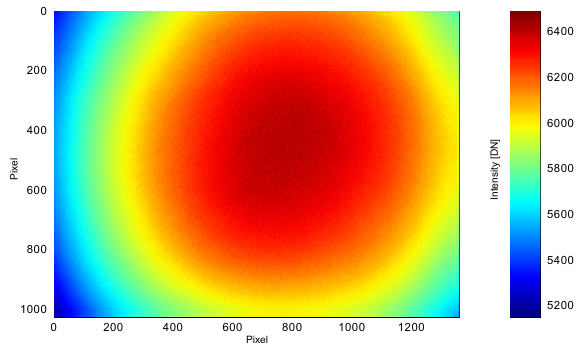
Figure 4: Flat field image (FFI) of the LED backlight, averaged over 100